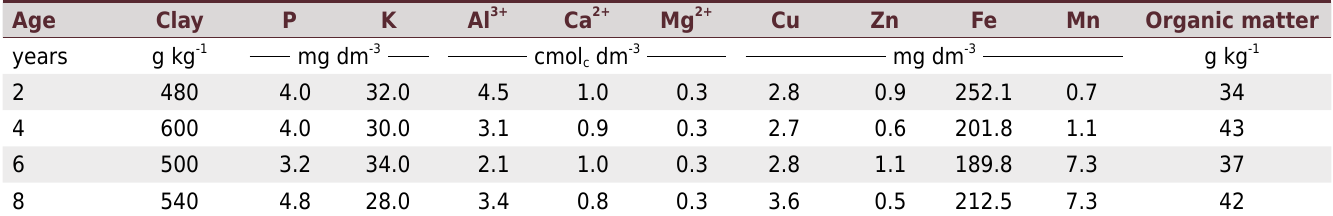
The analyses were performed according to the methods described by Tedesco et al.